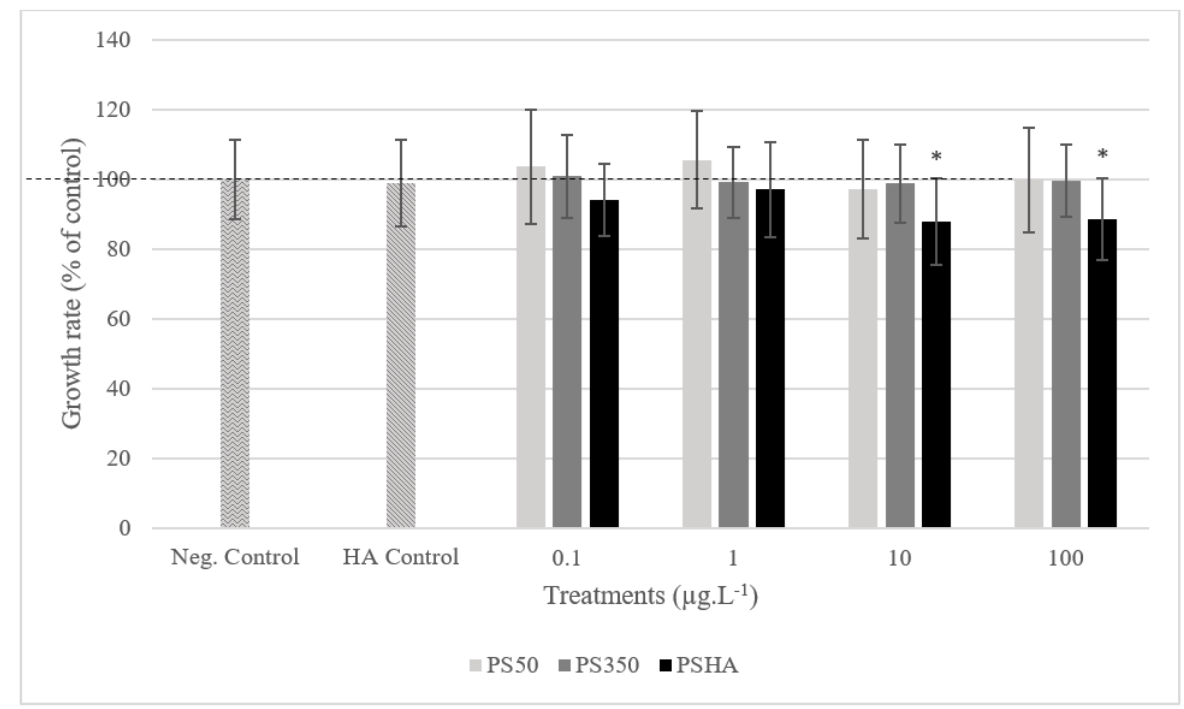
Figure 2. The growth rate of chironomid larvae exposed to PS50, PS350, and PS-HA. Error bars show the standard deviation of mean values. *: significantly different from control (Kruskal–Wallis test, p < 0.05).